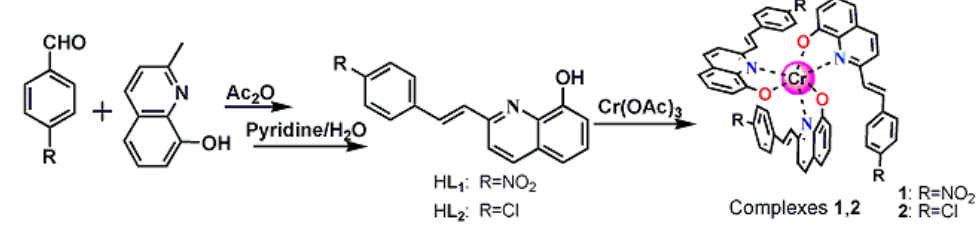
Table 2. Selected Bond length for 1 and 2